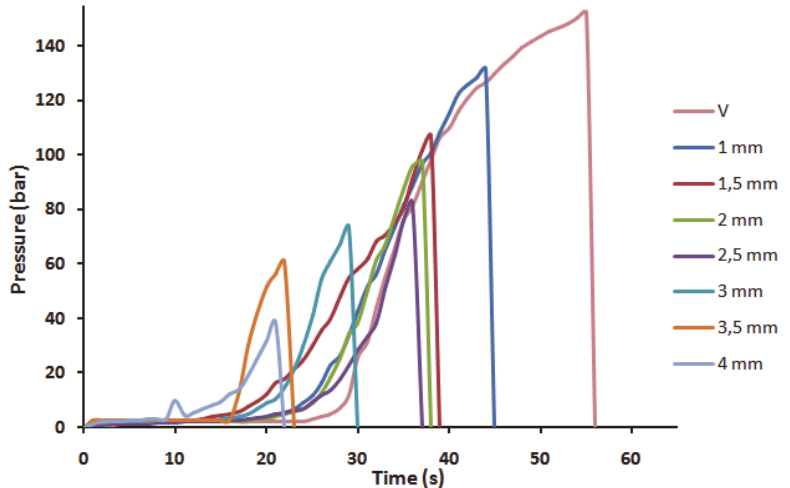
Figure 6: Evolution of the internal pressure according to time for virgin and notched CPVC